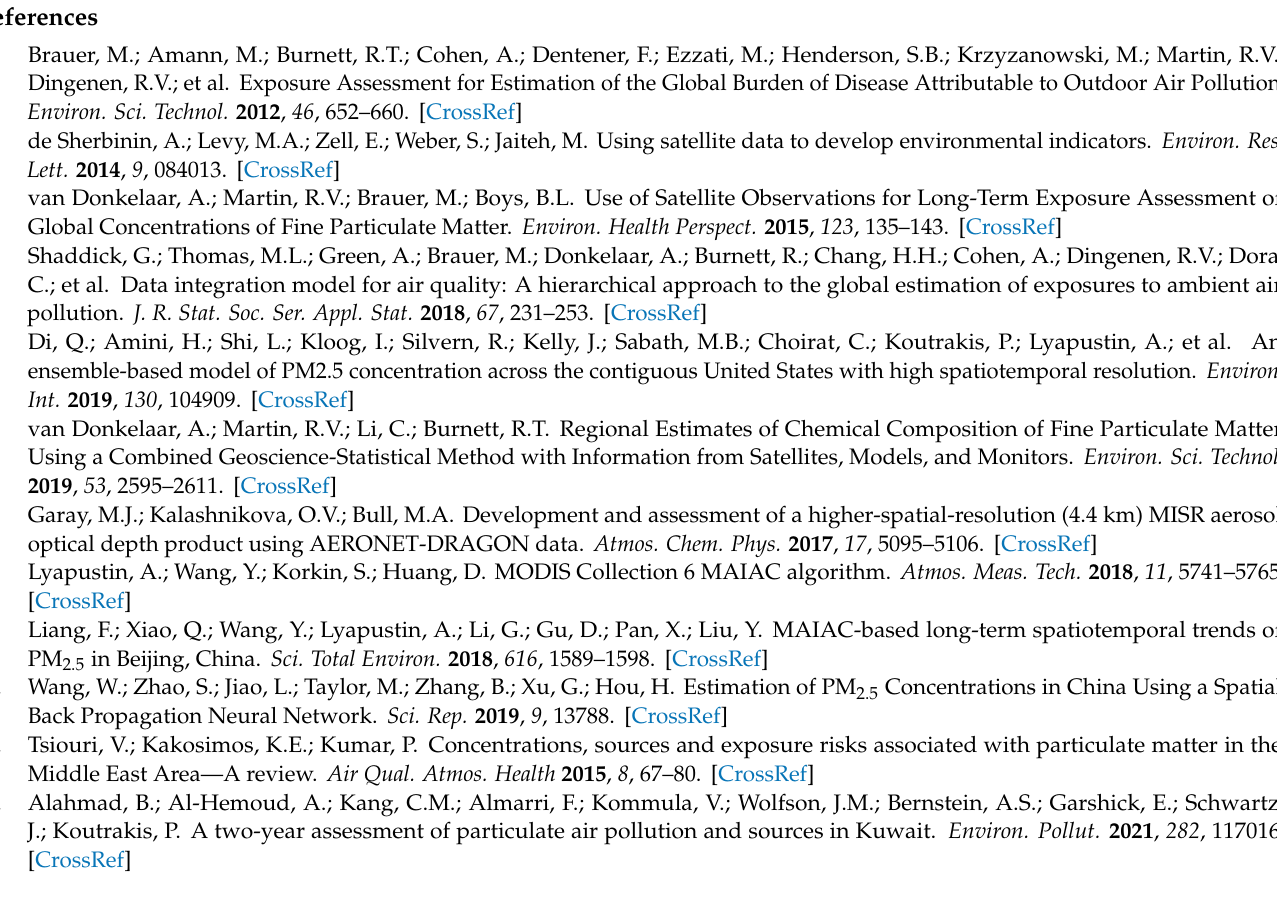
Figure A3. Autocorrelation functions for MERRA-2 assimilated aerosol extinction variables, includ- ing dust, sulfate, black carbon, and organic carbon. The Kuwait City and Central monitors shared the same MERRA-2 pixel and, thus, the same ACF. Organic carbon was not found to be useful in any models and was excluded in the final PM 2.5